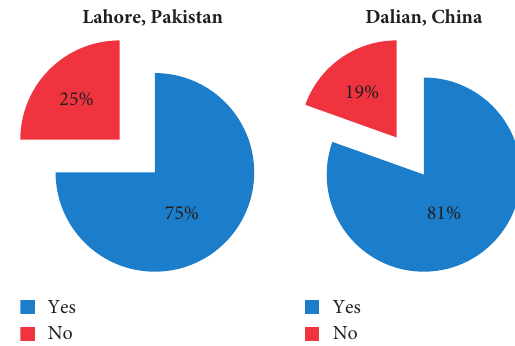
Figure 4: Awareness of respondents about SAVs in Lahore and